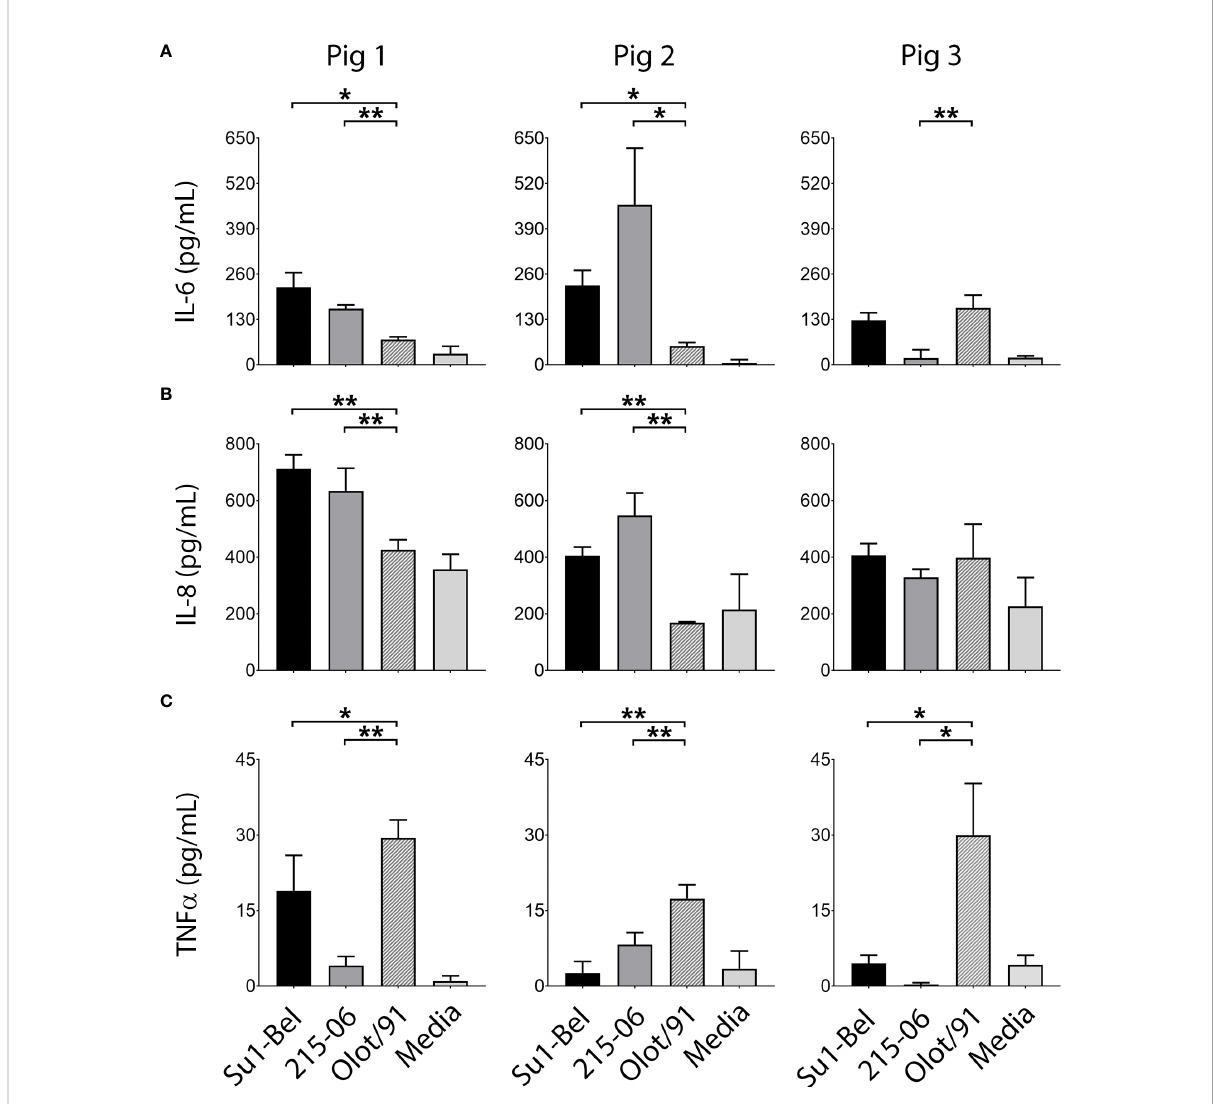
FIGURE 2 Virulent PRRSV-1 strains induced higher expression of IL-6 and IL-8 and lower expression of TNF- a than the attenuated Olot/91 strain. BMDM from three animals were infected (MOI 0.01) with PRRSV-1 strains of different virulence, SU1-Bel, 215-06 and Olot/91 and at 48 hpi supernatants were analyzed for (A) IL-6, (B) IL-8 and (C) TNF- a by cytokine-speci fi c ELISA. Experiments were performed on three separate occasions. Data is presented as the mean +/- standard deviation (* p < 0.05, ** p <